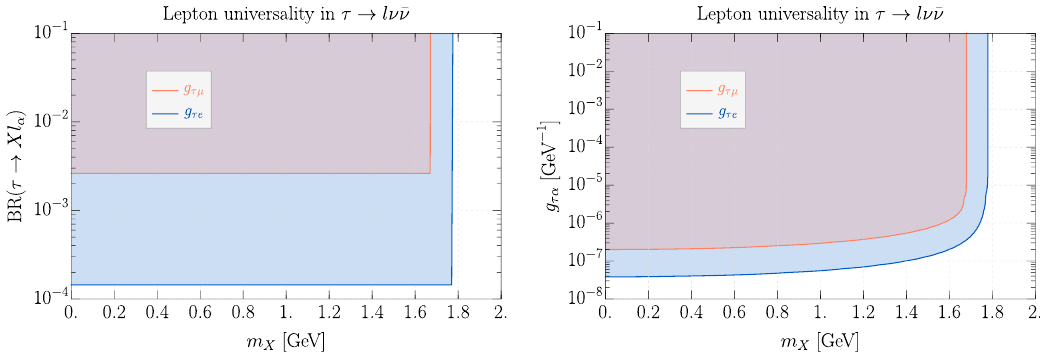
Figure 4 . Constraints on BR ( τ → Xl α ) (left) and on g τα (right) as a function of m X , derived from the upper bounds on lepton-universality violation in τ → l + missing, for Scenarios 1 ( g τe 6 = 0 ) and 2 ( g τµ 6 = 0 ). These limits are valid for long decay lengths of the X (small diagonal couplings g ee or g µµ ), so that it rarely decays inside the